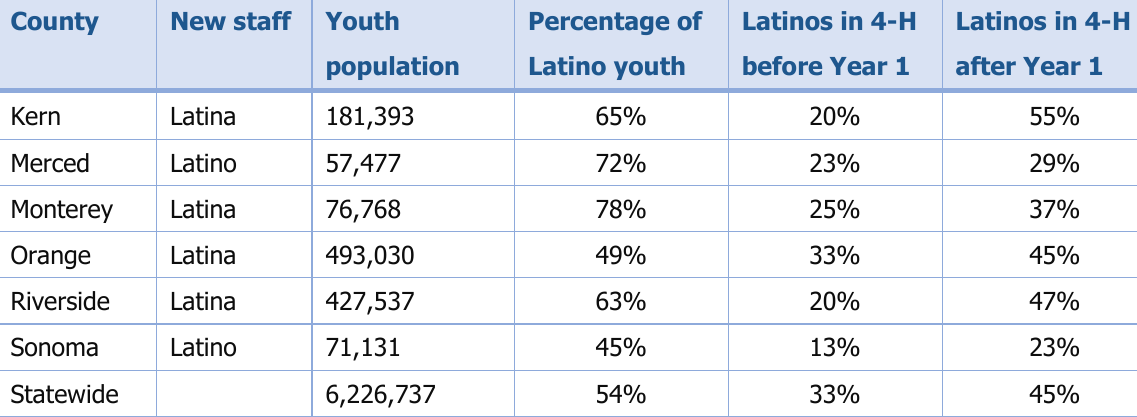
Table 1. University of California 4-H Latino Initiative: Latino Participants in 4-H Before and After Year